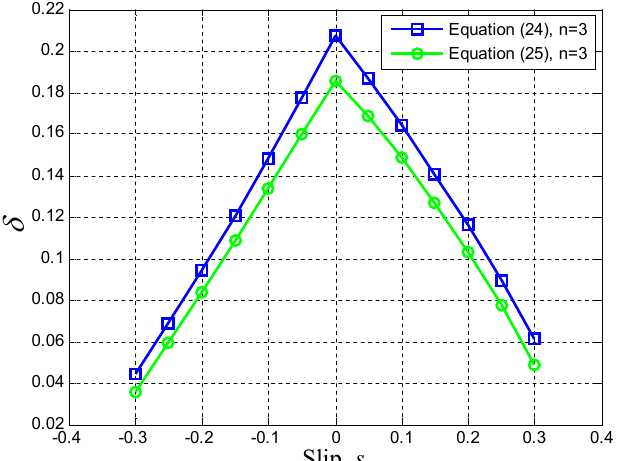
Figure 4. Controllable regions of a DFIG-based wind energy conversion system (WECS) through its operative slip